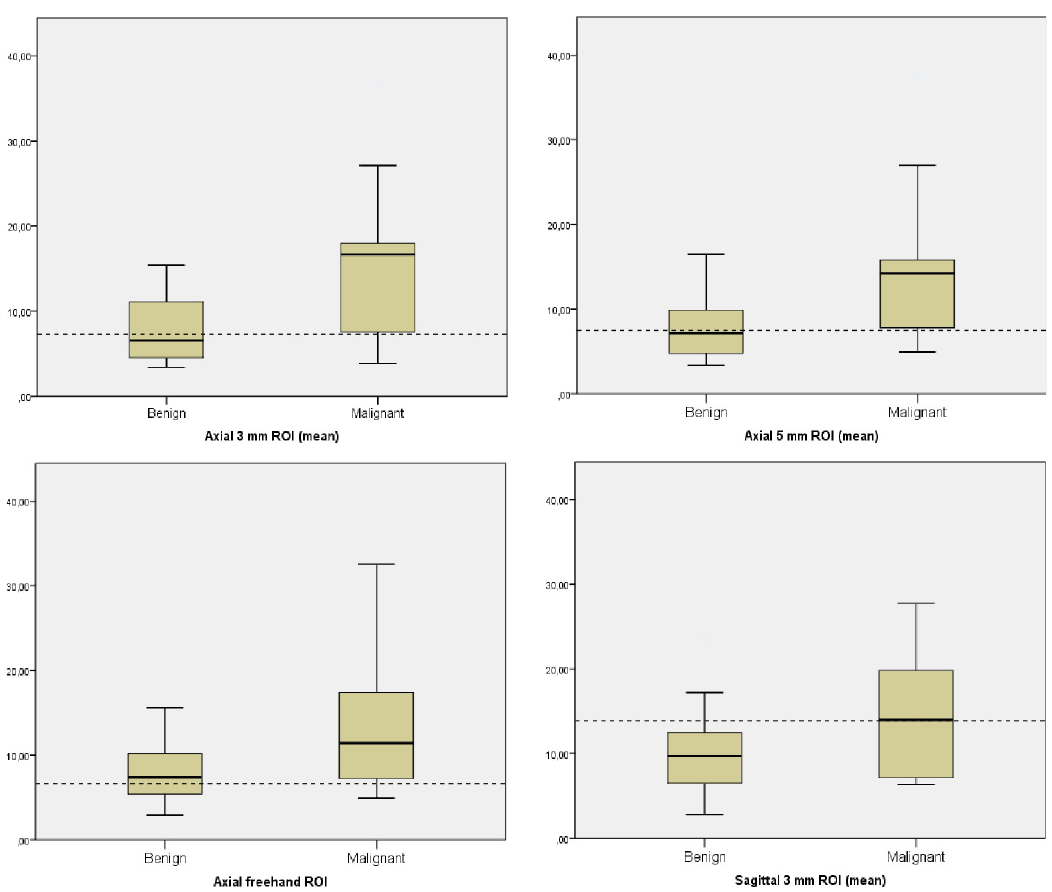
Fig 5. Boxplots of several different types of ROIs. Boxplots of axial 3 mm, 5 mm and freehand ROI and sagittal 3 mm ROIs in benign vs. malignant lymph nodes with the elasticity cut off values (kPa) from the ROC-curve (black dotted line). Axial ROIs demonstrated better diagnostic performance than sagittal